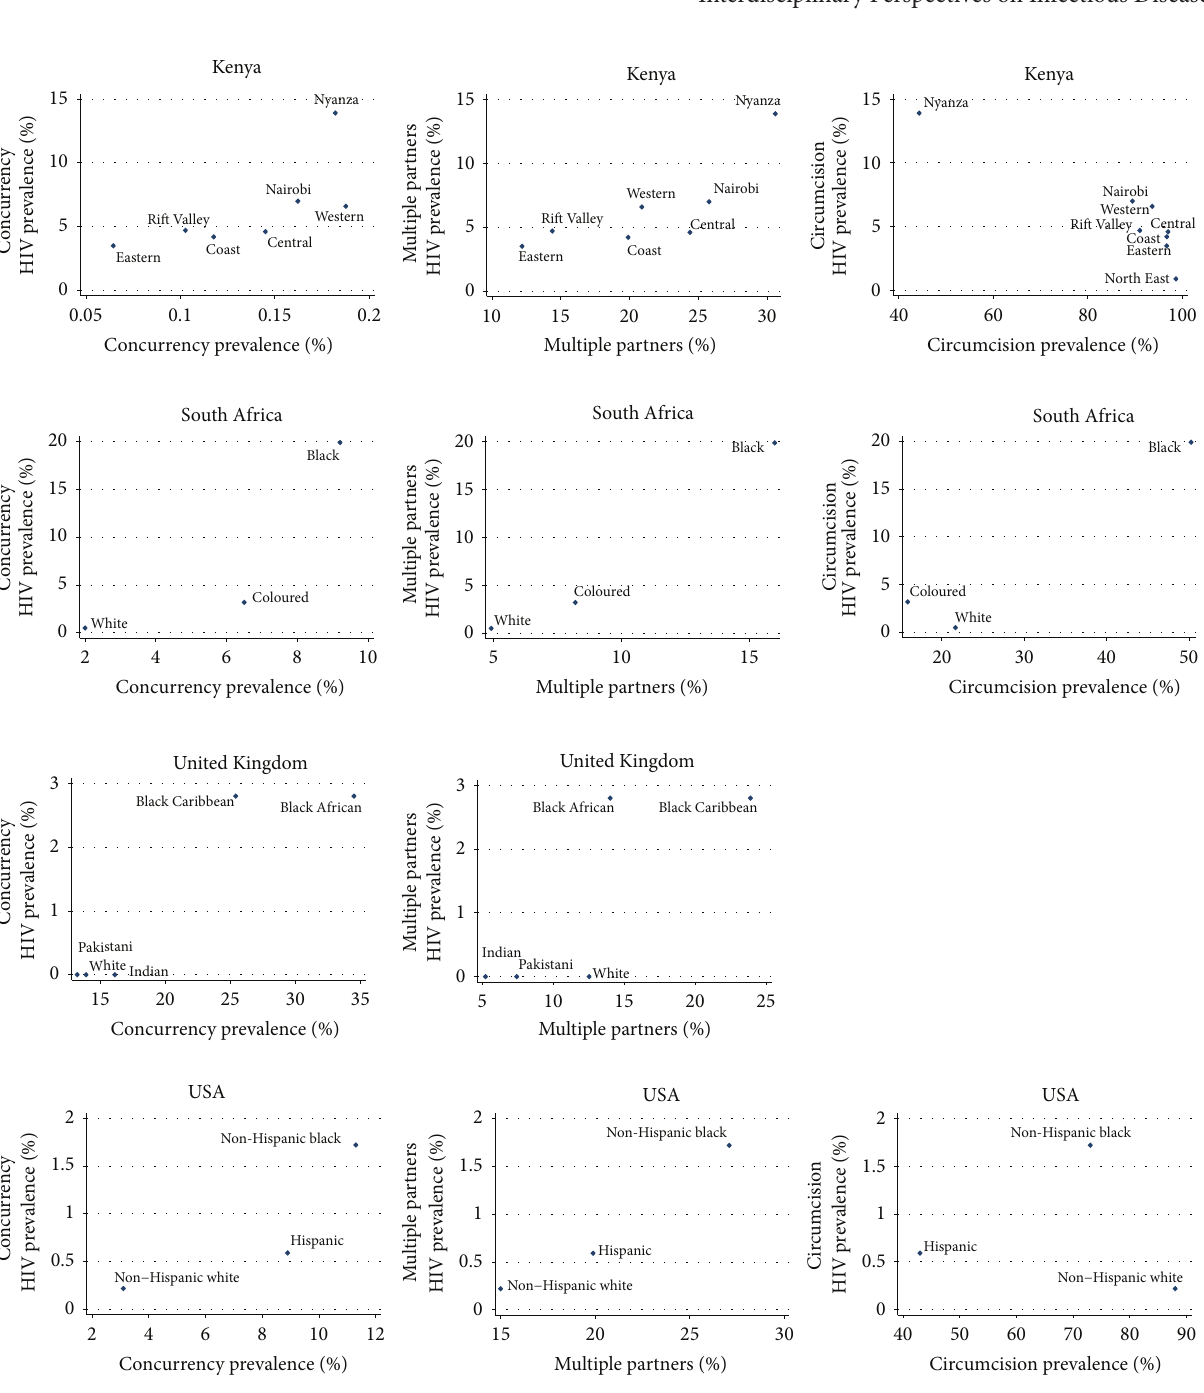
Figure 2: The prevalence of concurrency, multiple partnering, and circumcision versus HIV prevalence by ethnic group in Kenya, South Africa, the United Kingdom, and the United States of